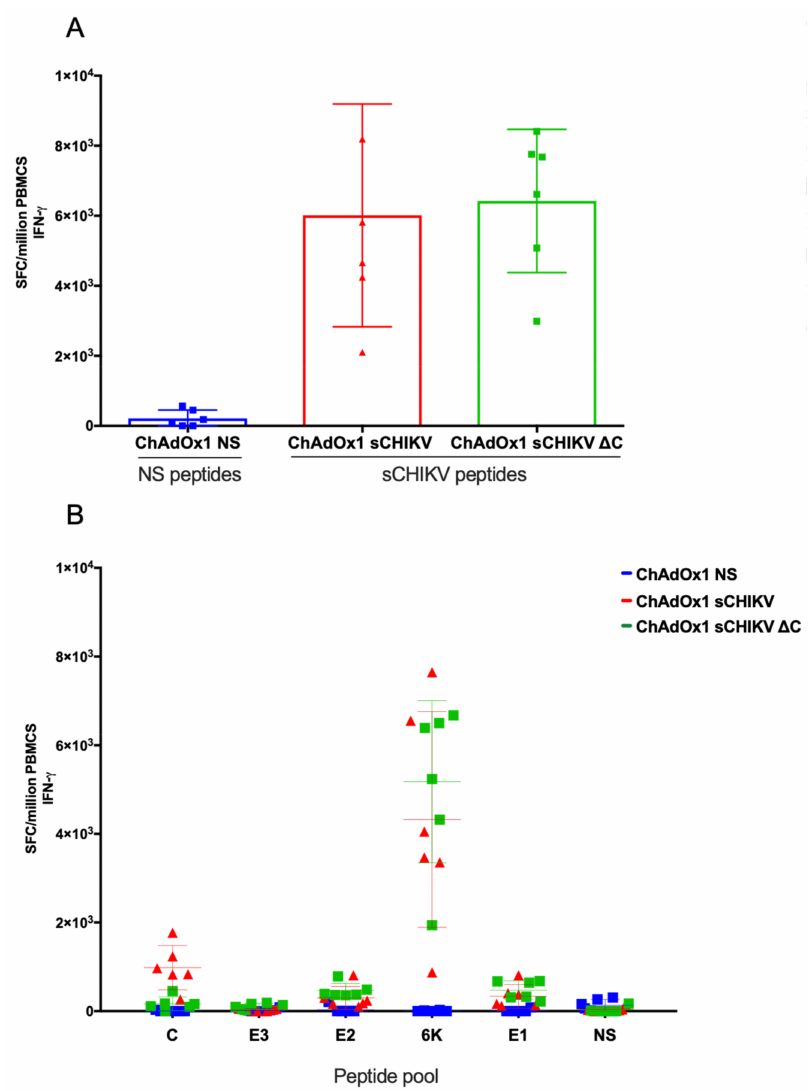
Figure 4. Cellular immune responses elicited by ChAdOx1 vaccines. ( A ) BALB/c mice ( n = 6 per group) were immunised intramuscularly (i.m.) with a dose of 10 8 I.U. of ChAdOx1 vaccines. Peripheral blood mononuclear cells (PBMCs) were cultured with a peptide pool containing the CHIKV structural antigens by ELISpot for IFN γ producing cells. ( B ) ELISpot from the same mice, using deconvolution of peptides spanning the C, E3, E2, 6k and E1 regions, respectively. Values represent the spot-forming cells (SFC) per million PBMCs. 20-mer peptides spanning the CHIKV structural polyprotein (10 µ g/mL) were used for stimulation. Line colours and shapes represent mice vaccinated with each